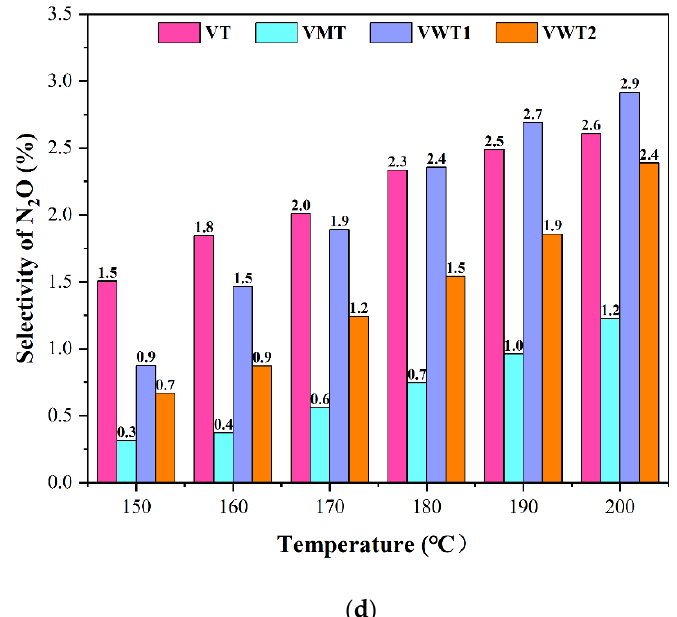
Figure 2. ( a ) The selectivity of COx without NO/NH 3 ; ( b ) The selectivity of COx without NO/NH 3 ; ( c ) The selectivity of HCl with NO/NH 3 ; ( d ) The selectivity of N 2 O.